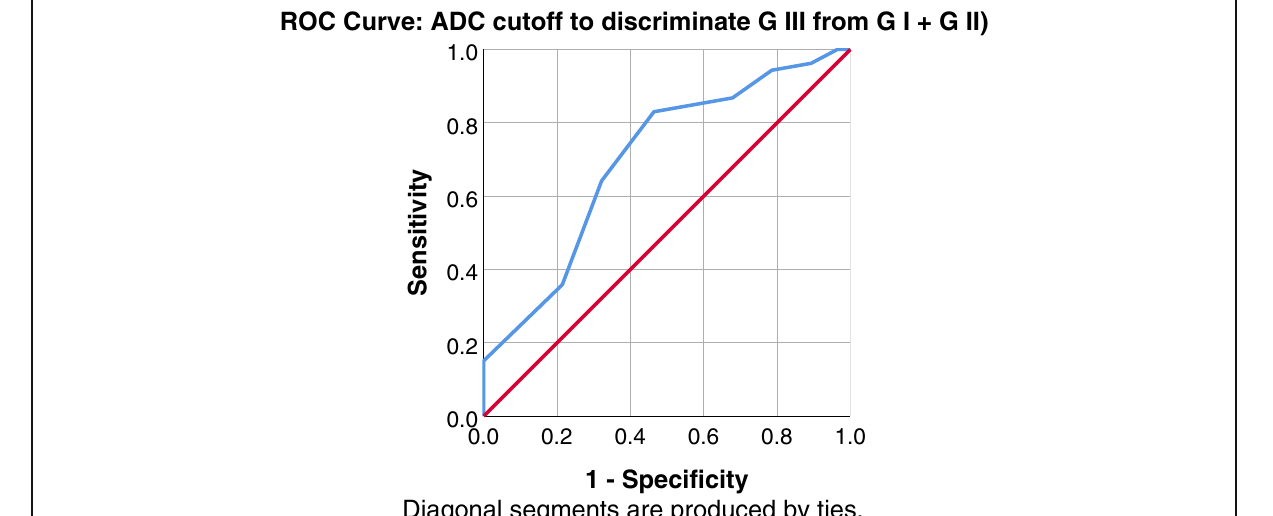
Diagonal segments are produced by ties. Fig. 8 Receiver operator characteristic curves show ADC cut off to discriminate GIII from GI and GII, AUC =